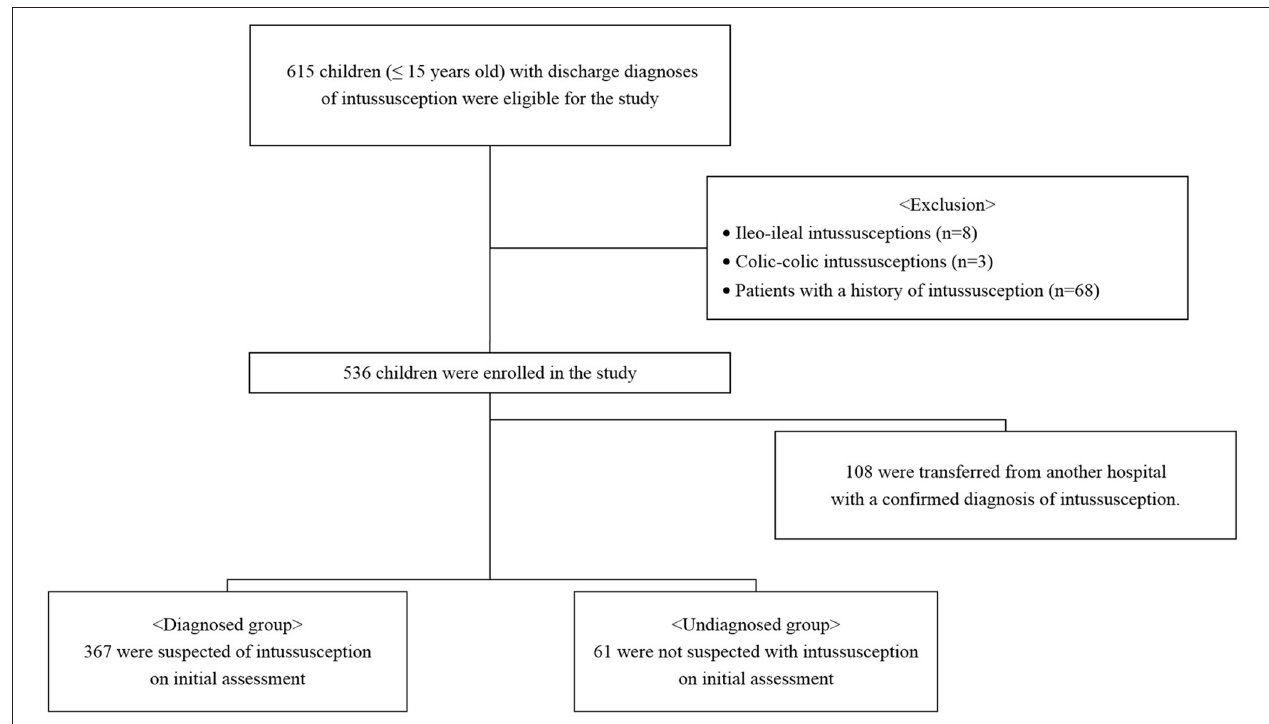
FIGURE 1 | Flow chart of study population.